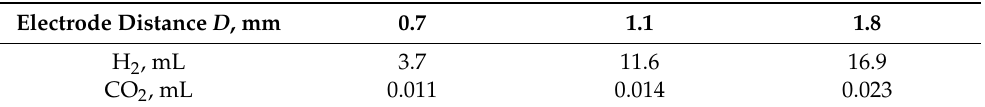
Table A1. Product gas yields * from solution-plasma treatment of 100 mL NaCl solution (0.1 g/L) at various electrode distances for 30 min